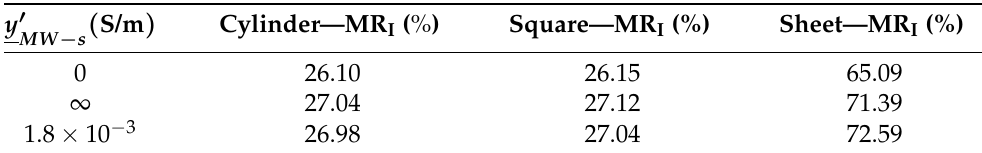
Table 4. Current mitigation rate yielded by different values of the mitigation wire p.u.l. admittance to earth y (cid:48) MW − s